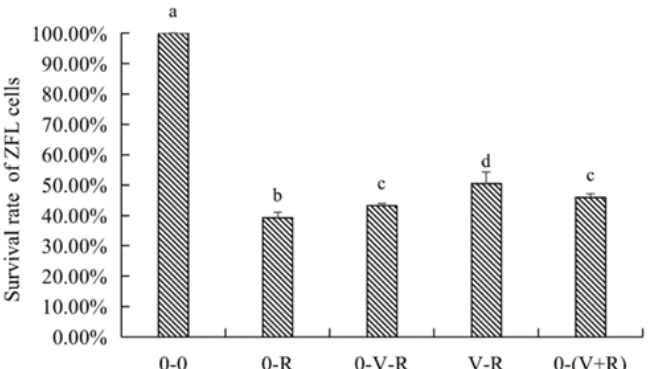
Figure 2. Effects of different incubation patterns of 1,25(OH) 2 D 3 on survival rate of ZFL after being treated with 3 µ M RSL3 for 6 h ( n = 6). Error bars represent the standard error of each group. Means with different superscript letters (a, b, c, d) are significantly different ( p < 0.05),while the same letter means no statistical difference between two groups.